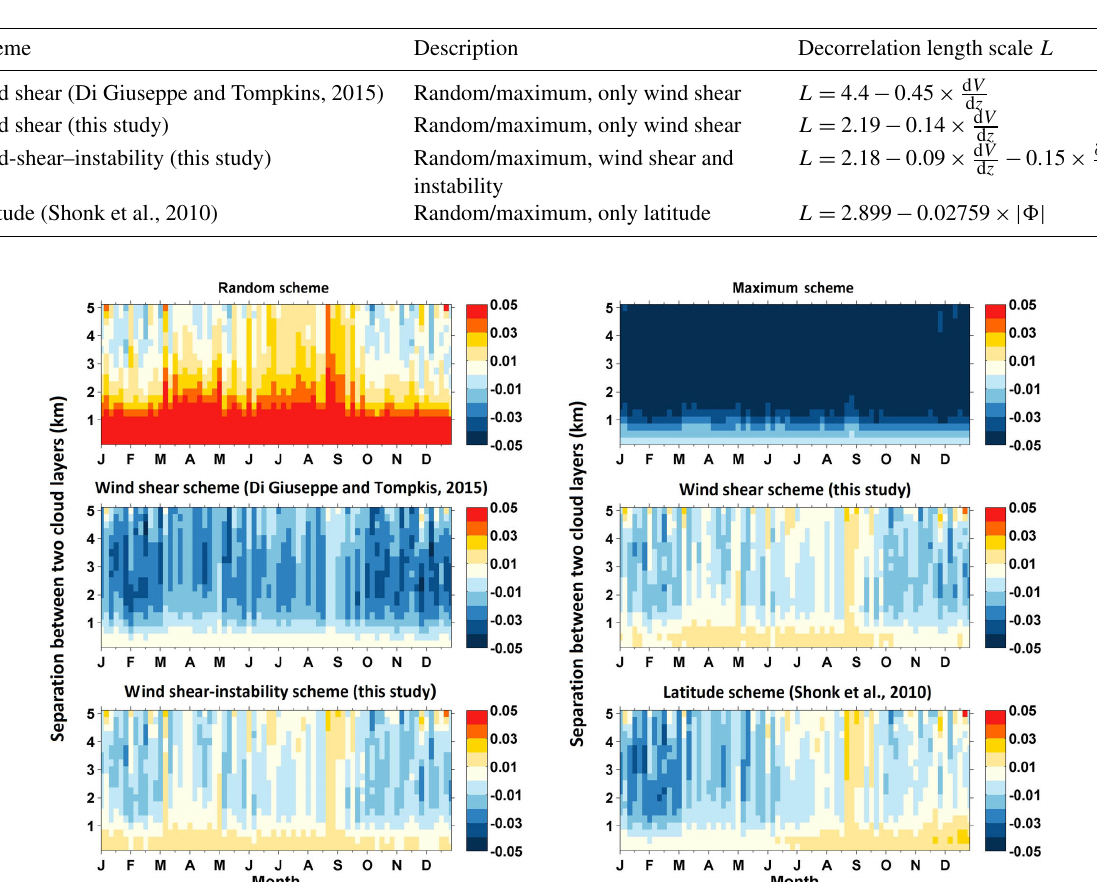
Table 1. Parameterizations of decorrelation scale length L from the exponential fit as a function of atmospheric stability ∂θ es /∂z , wind shear d V/ d z or latitude (cid:56) .